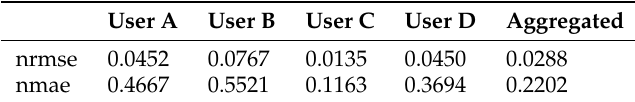
Table 6. Error metrics on